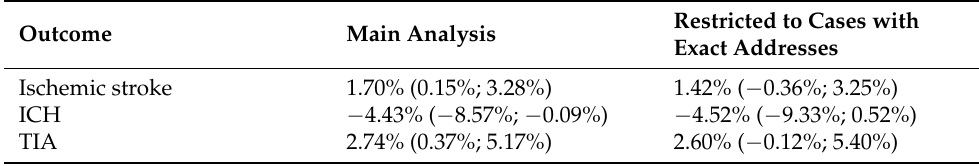
Table 3. A sensitivity analysis restricting the data to cases with exact addresses.